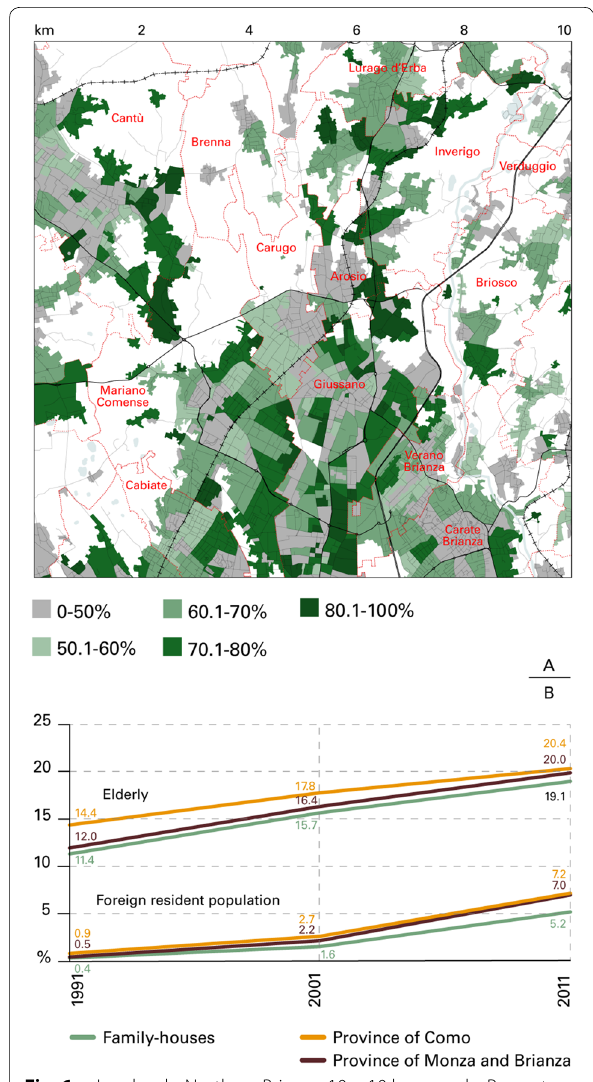
Fig. 6 a Lombardy, Northern Brianza, 10 10 km sample. Percentage × of one- and two-interior buildings built in the period 1961–1991 out of the total residential stock at 2011 (authors’ calculations on data from Istat census). b Lombardy, Northern Brianza: trends in the elderly and foreign resident population within the census blocks where family houses constitute more than 50% of the total housing (authors’ calculations on data from Istat